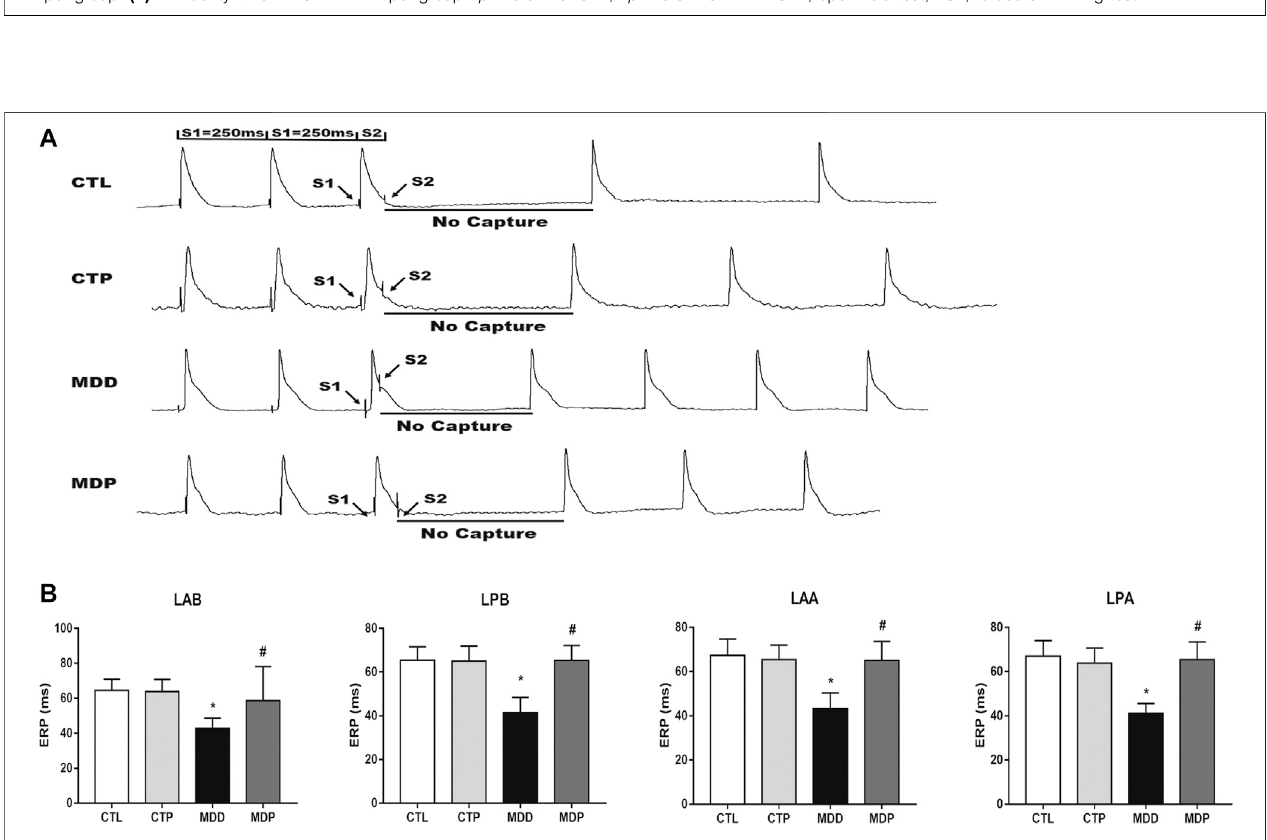
FIGURE3| Monophasicactionpotentials. (A) Representativerecordingsofventricularelectrogram. (B) ERPatfourepicardialsites,respectively.n (cid:1) 10pergroup. * p < 0.01 vs. CTL; # p < 0.01 vs. MDD. ERP, effective refractory period.